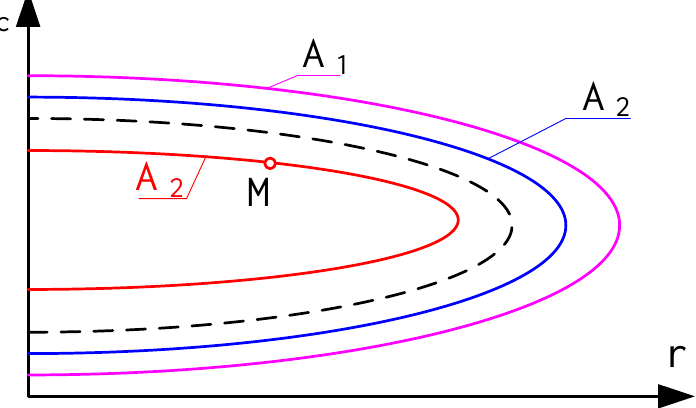
Figure 3. Asynchronous border movement self-excitation in the process establishment. point M are caused by the inequalities xd